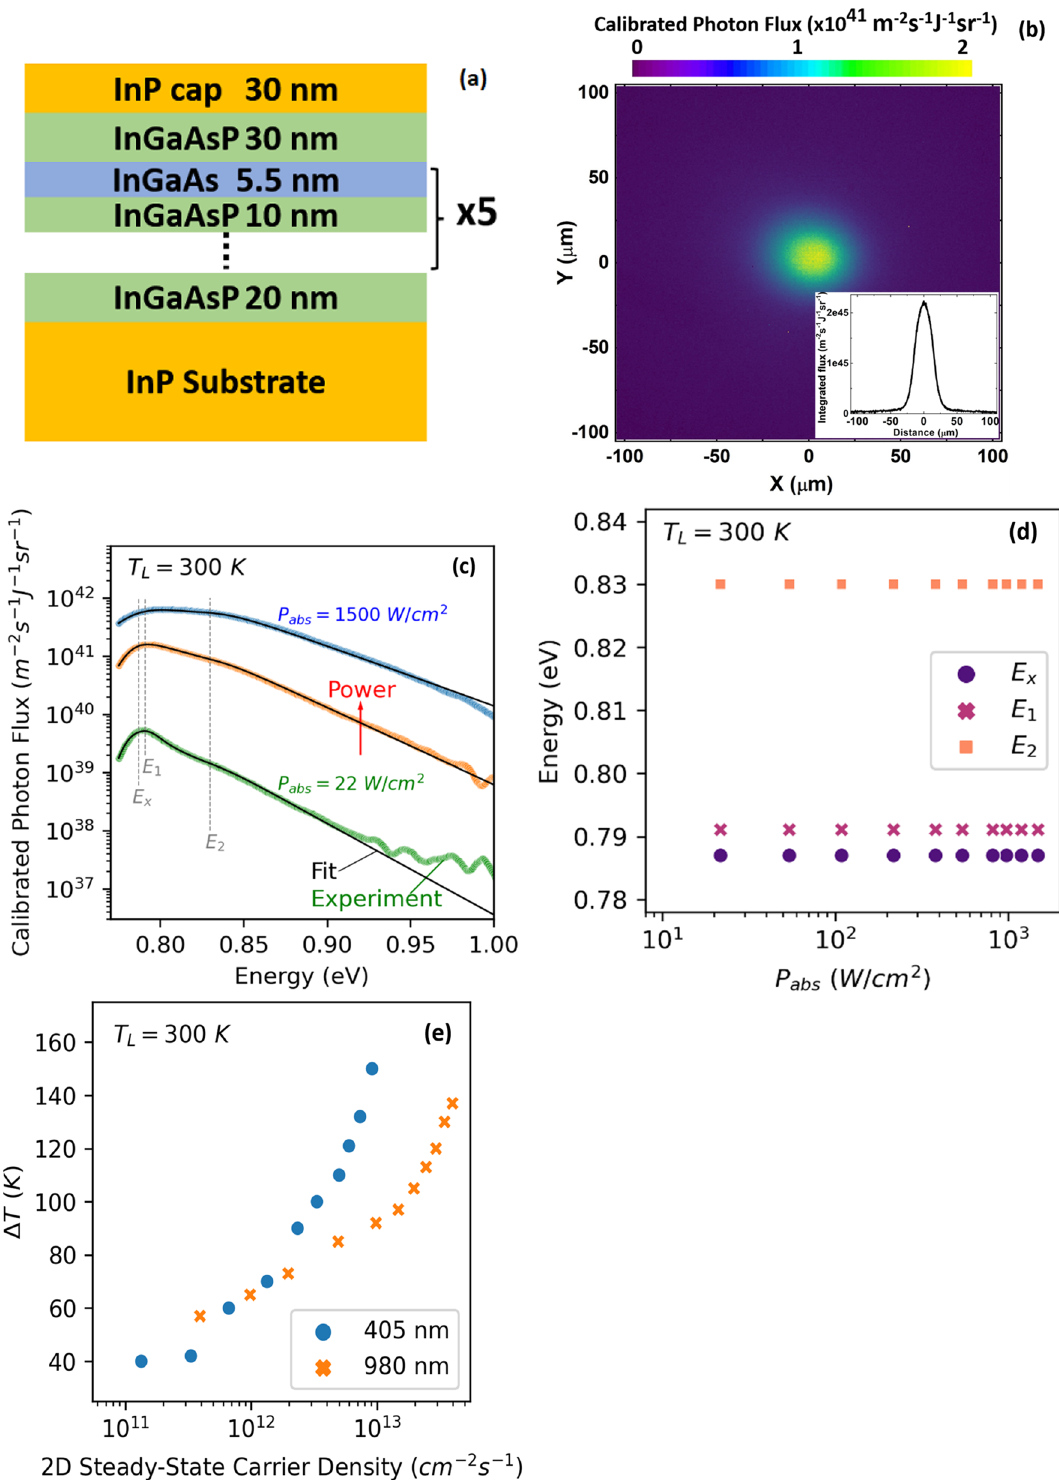
Figure 1. Photoluminescence (PL) characterization of the multi-quantum well (MQW) structure. ( a ) Schematic of the MQW structure (not to scale). ( b ) PL map of the InGaAs MQW at 300 K registered by the hyperspectral luminescence imager. The inset is a line scan of the PL map, which indicates the homogeneity of the luminescence. ( c ) PL spectra of the InGaAs MQW structure at 300 K under various excitation powers of the 405 nm laser. The black lines indicate results of the full spectrum fit. The energy positions of optical transitions in the QW structure are labeled by E x , E 1 , E 2 . The E x is due to excitons. ( d ) The optical transition energies as a function of absorbed power density. ( e ) The hot carrier temperature difference (cid:31) T versus the 2D steady-state carrier density at 300 K under 980 nm and 405 nm excitation